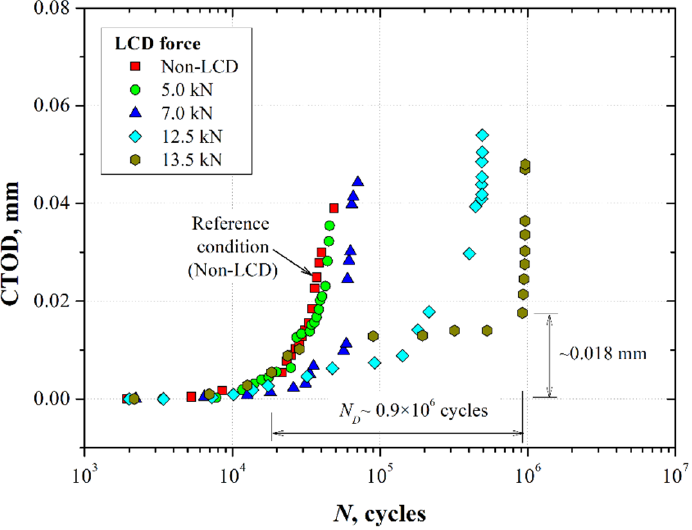
Figure 9. Crack tip opening displacement as a function of the number of fatigue cycles for the 7075- T651 aluminum alloy specimens subjected to the localized compressive deformation